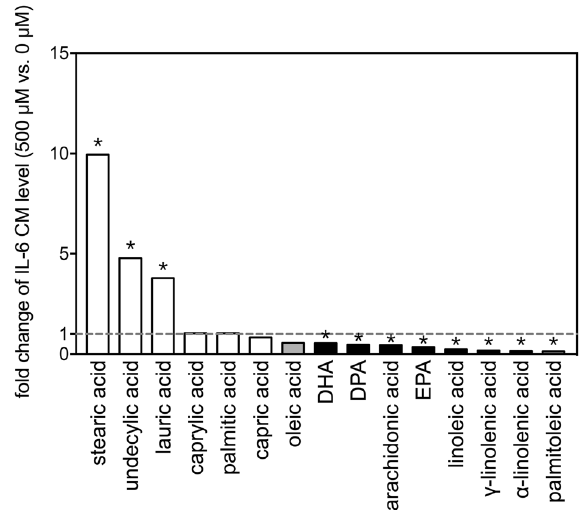
Figure 6. Fold-changes of IL-6 levels after treatment with selected fatty acids. Fold changes in levels of IL-6 in the conditioned media between 500 µM and 0 µM (vehicle control) of the 15 FAs after incubation with THP-1 cells for 24 h. The asterisks indicate significance in post-hoc comparison (500 µM vs. 0 µM) shown in Fig.